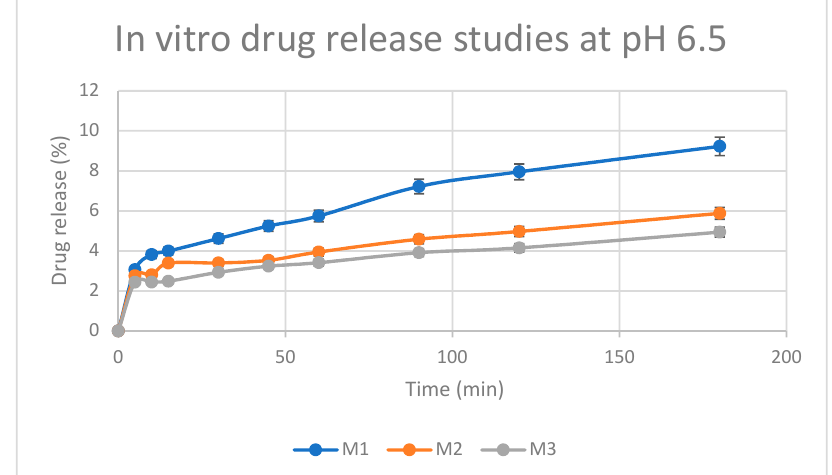
Figure 13. Release profile of 5-FU incorporated in chitosan–BTC hydrogels (M1, M2, and M3) investigated in phosphate-buffered saline (PBS) medium, pH 6.5 Results represent mean values ± SD; n = 3 (For M1 and M2: p < 0.05; M1 and M3: p < 0.05).